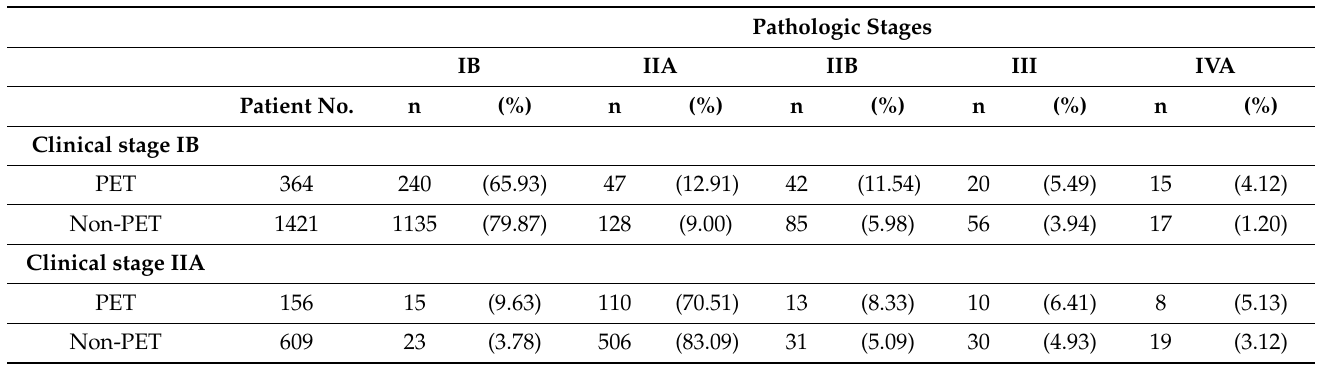
Table 3. The change of stage (clinical stage convert to pathologic stage) for PSM patients receiving thoracic